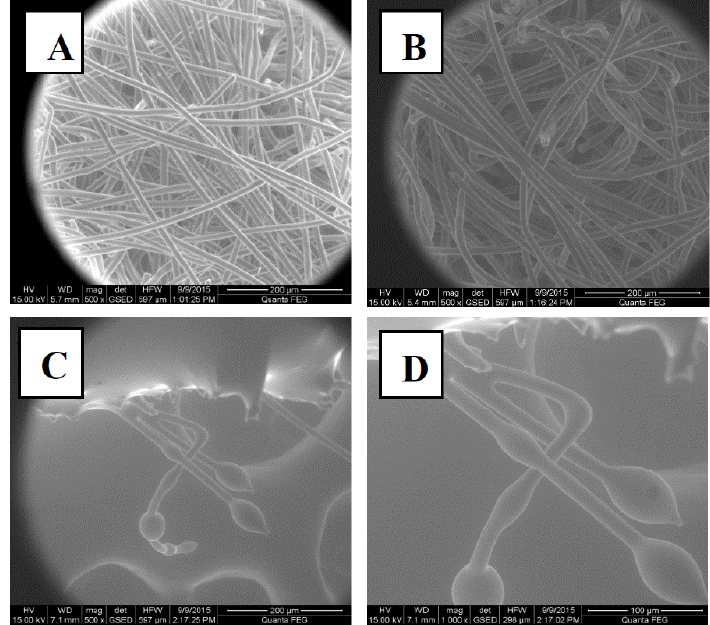
Figure 4. FEGSEM of dry TENCEL ® fibres ( A ), synthetic MGO-coated fibres ( B ) and MH-coated fibres ( C , D ) taken at a magnification of 500× ( A – C ) and 1000× ( D ). The concentration of MGO on both the MGO- and MH-coated samples was 0.1 mg cm 2 . The diameter of the uncoated TENCEL fibres ranged between 10 and 15 µ m. The MGO-coated fibres ranged from 10 µ m to 25 µ m (this is due to the swelling of the TENCEL fibres after coating).